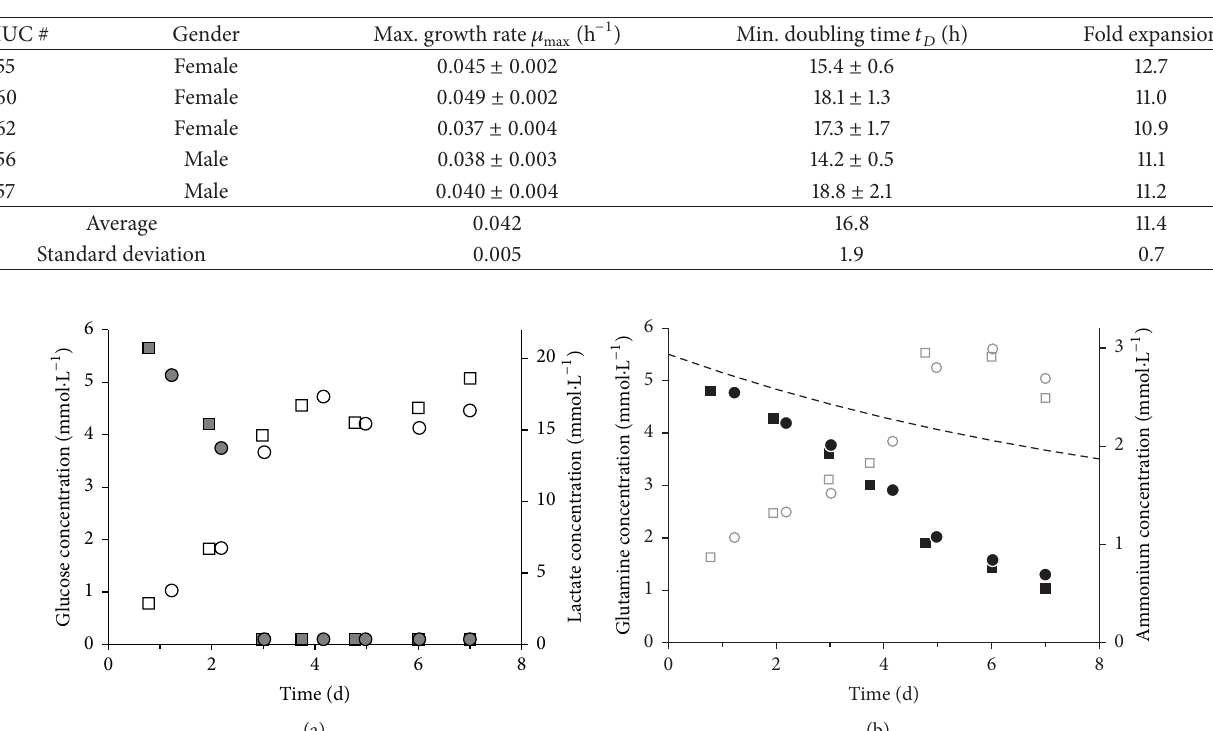
Table 2: Maximal growth rate, minimum doubling time, and fold expansion of hUC MSCs from five donors, after 7 days in culture in 1mL